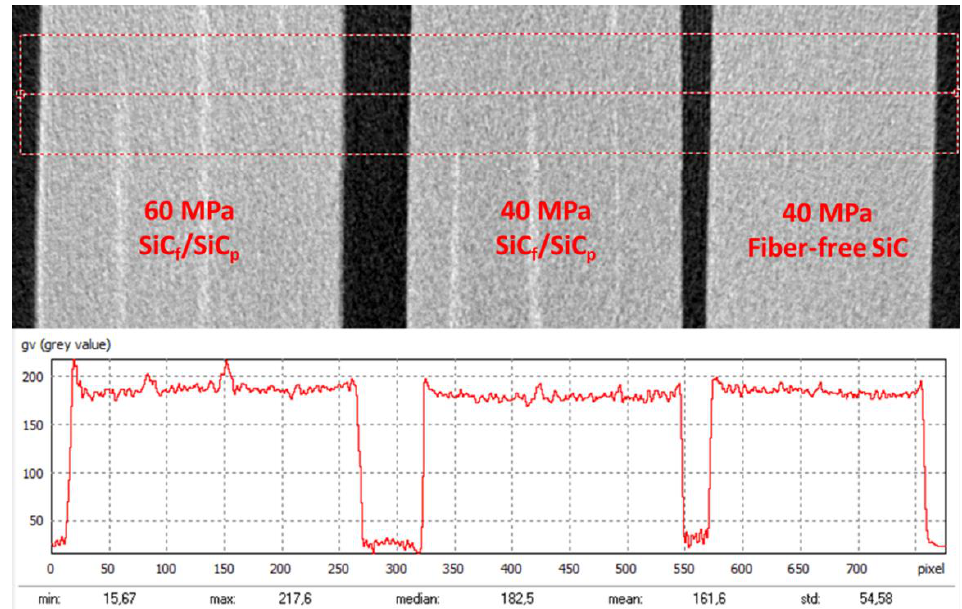
Figure 6. The X-ray density of the samples by the integrated profile.